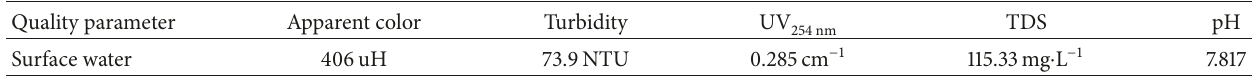
Table 3: Characterization of surface water.